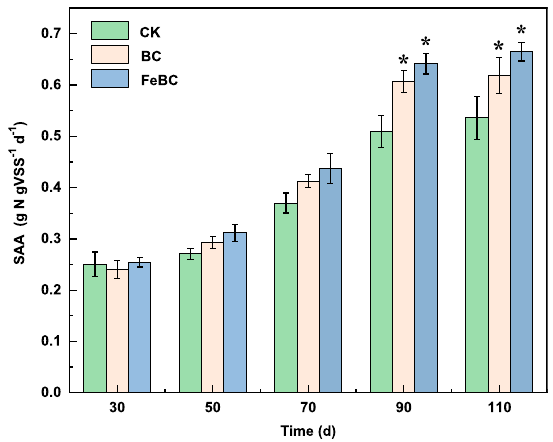
Fig. 4 The specific anammox activity (SAA) of the three anammox systems with the increased NLR. Asterisks indicate significance ( p < 0.05). VSS, volatile suspended